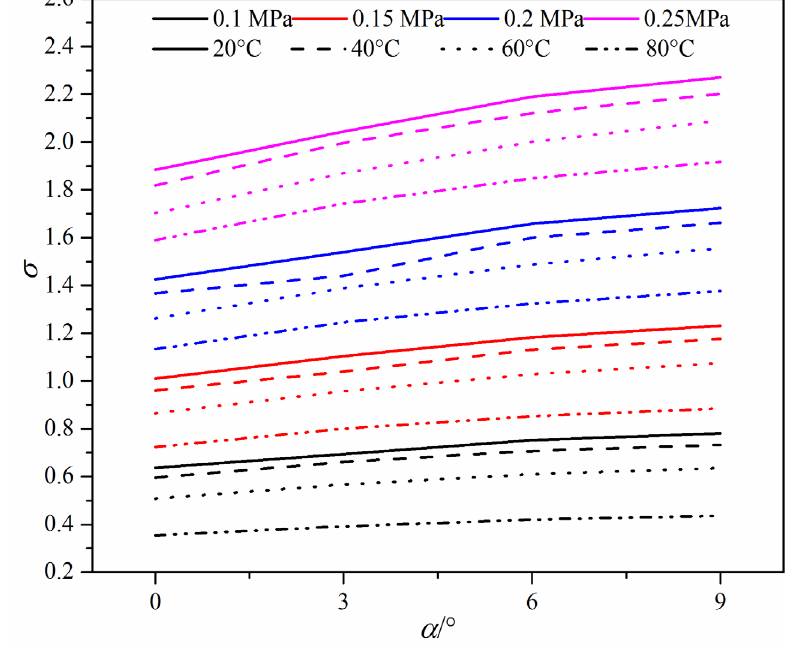
Figure 13. Cavitation number in the two-cage globe valve with different installation angles.